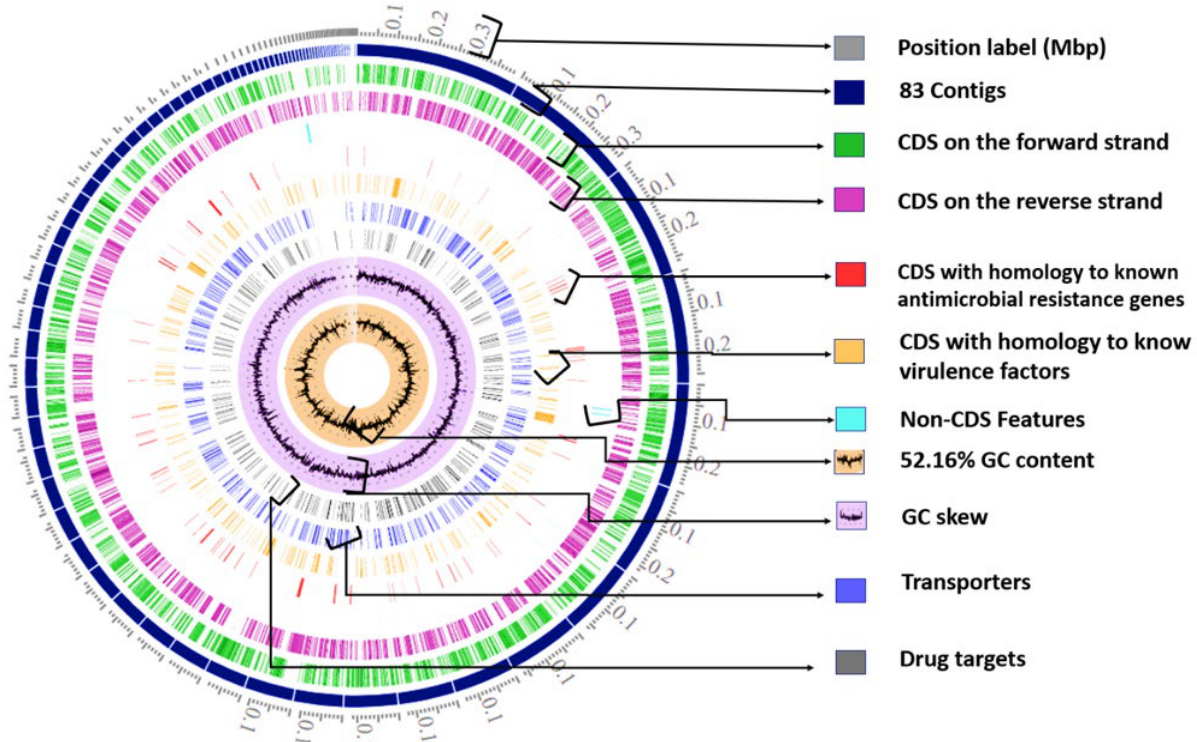
Figure 1. A circular graphical display of the distribution of the genome annotations of Salmonella enterica subsp. enterica Typhimurium 69M. The colors of the descriptive of the CDS elements of the Salmonella enterica subsp. enterica Typhimurium 69M were changed for the transparency of the view: grey for position label (MBP), navy for the contigs, green for the CDS on the forward strand, violet for the CDS on the reverse strand, turquoise RNA genes, red for the CDS with homology to known antimicrobial resistance genes, orange for the CDS with homology to know virulence factors, blue for the transporters genes, black for the drugs target genes, black line on orange background GC content, and black on purple GC skew (done with PATRIC-BV-BRC, https://www.bv-brc.org, accessed on 17 November 2022).